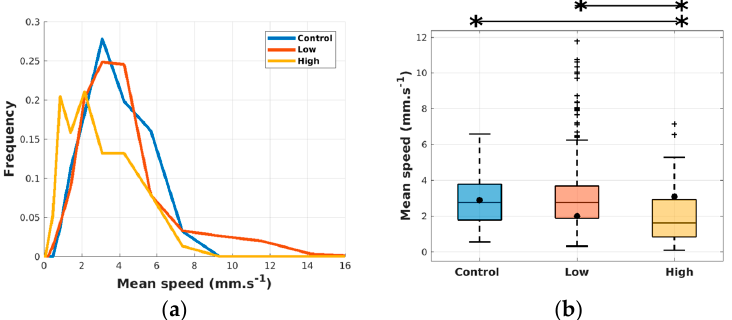
Figure 4. Trajectory-based mean swimming speeds of T. turbinata in the control group (with I. galbana only) and under MP addition at 100 (Low) and 1,000 beads mL − 1 (High). MP treatments contained I. galbana at the same concentration as in the control group. Copepods were observed after being transferred to filtered seawater. ( a ): frequency distribution. ( b ): trajectory mean speeds, lower and upper limits, and outliers. Horizontal bars on the top of the right panel represent statistical differences between groups.